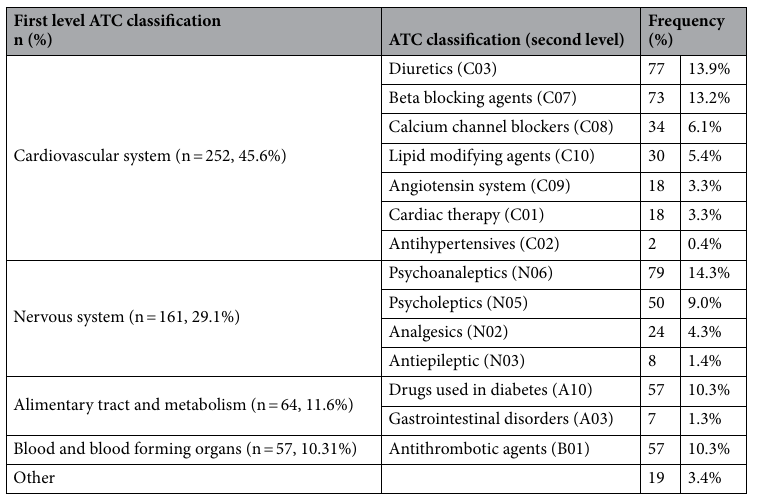
First level ATC classification n